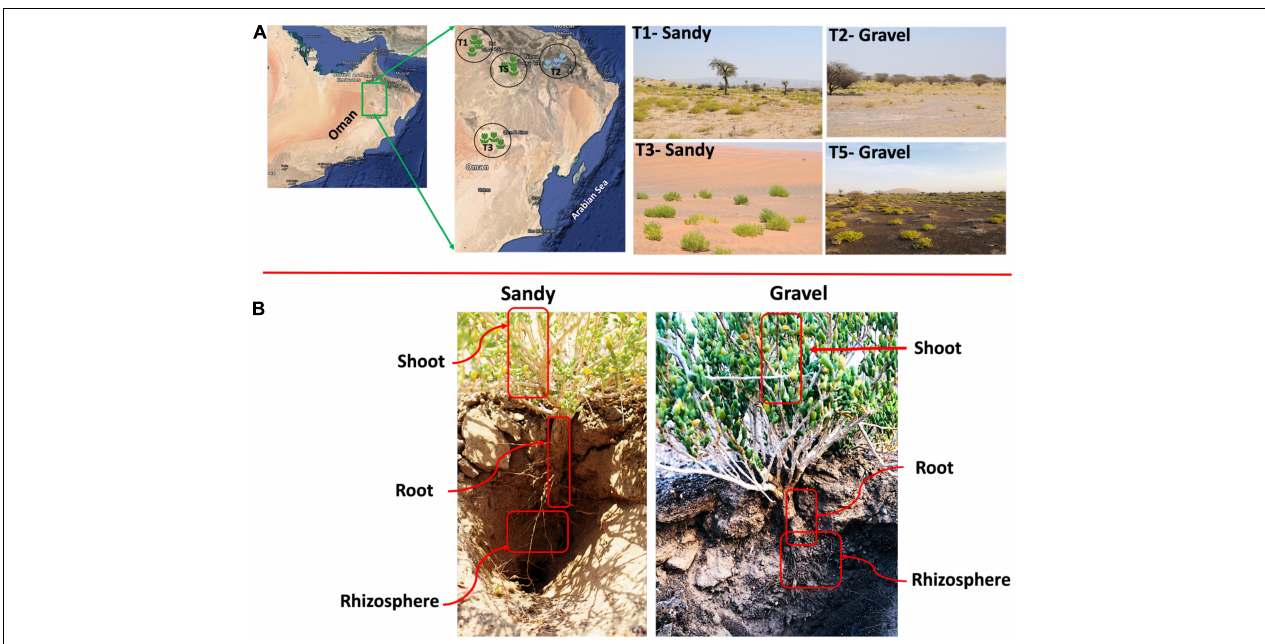
FIGURE 1 | Habitat of Z. qatarensis . (A) Location map of samples across different parts of desert ecosystem where Z. qatarensis grows. Mainly two populations (growing in gravel and sandy soils) were scattered from north to southern regions. (B) Samples were collected from bulk soil, rhizosphere, and root/shoot endosphere of sandy and gravel